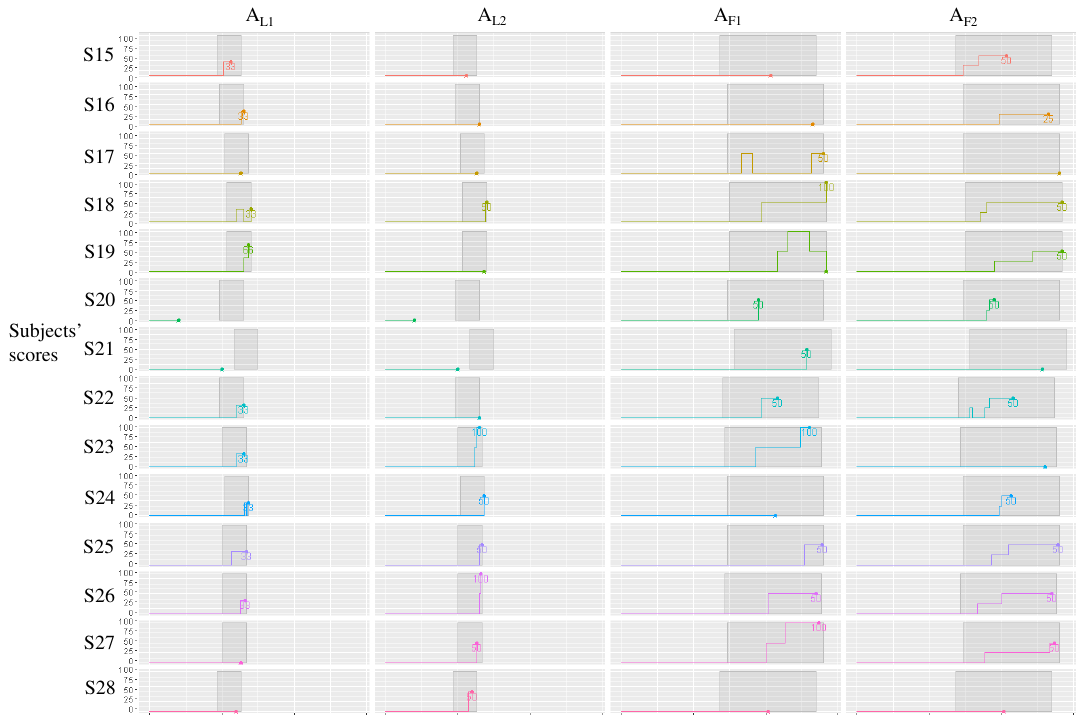
Figure 15. Changes in scores over time for each subject in the experimental group ( G E ).